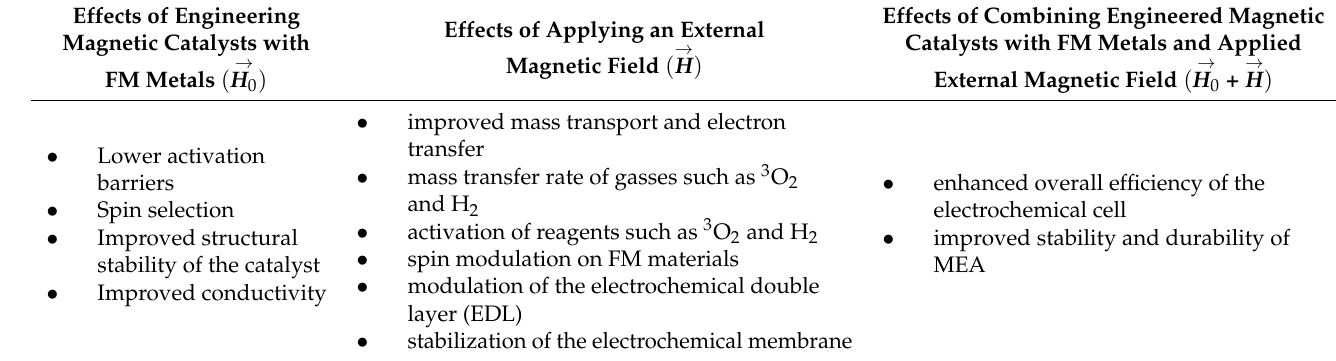
Table 10. Reported experimental effects in electrochemical processes and devices such as PEM fuel cells, when magnetic catalysts containing FM metals ( → H ) and when the two effects are combined ( field is applied (